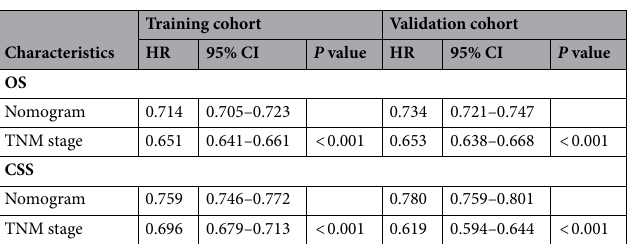
Table 5. Comparison of C-indexes between the nomogram and TNM stage in gastric cardia cancer (GCC) patients . HR hazard ratio, CI confidence interval.